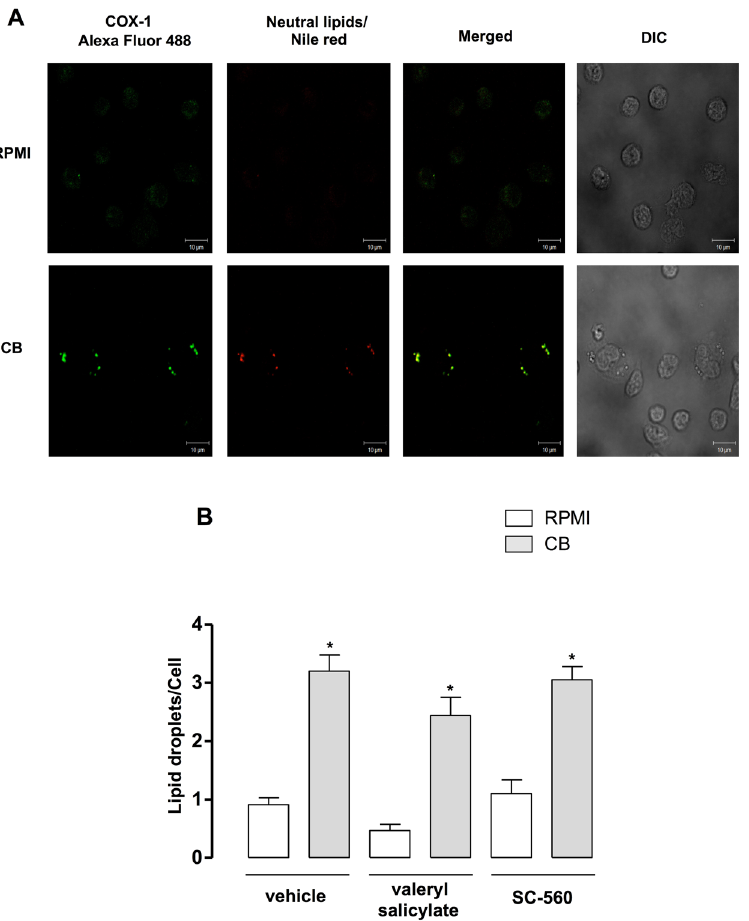
Figure 8. CB-induced cytoplasmic LDs compartmentalize COX-1, but this enzyme is not involved in LDs formation. ( A ) Macrophages incubated with RPMI (control) or CB (0.4 µ M) for 3 h were labeled for LDs (Nile Red) and for COX-1 (anti-COX-1 antibody, Cayman Chemical). The merged image shows colocalization of COX-1 to LDs. The pictures are representative of three independent experiments. ( B ) Treatment of macrophages with valeryl salicylate (450 μ M) or SC-560 (0.5 μ M) a COX-1 inhibitors for 1 h, before stimulation with CB (0.4 µ M) for 3 h. LDs were counted using light microscopy after osmium staining. Each bar represents the mean ± SEM of the number of LDs/cell in 50 cells. Values represent means ± SEM for three to five animals. * p < 0.05